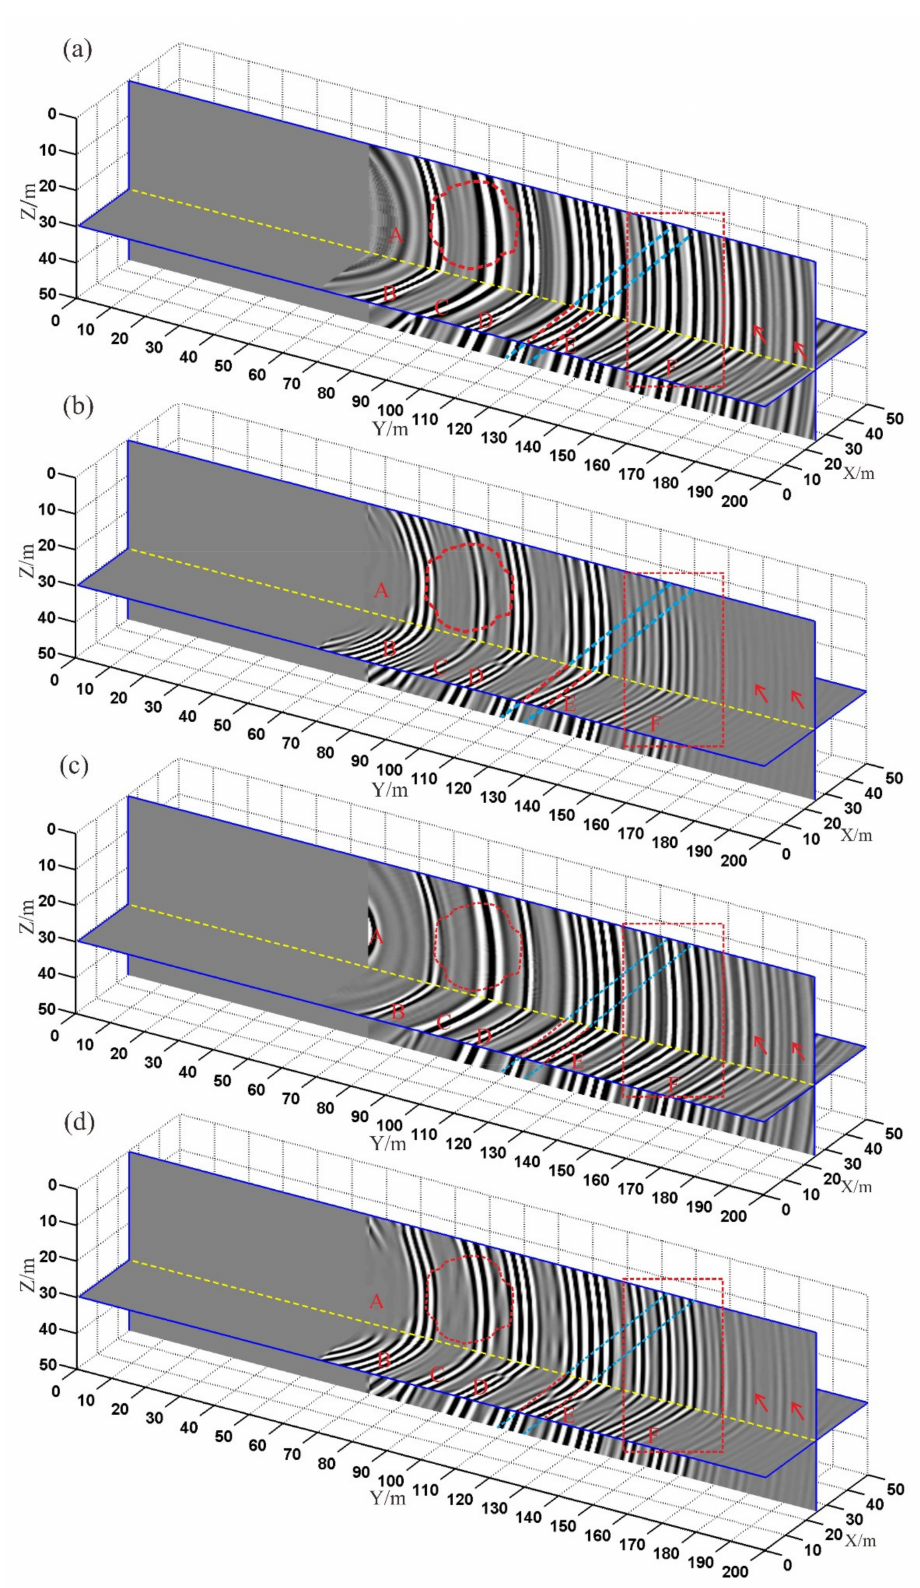
Figure 6. 3-D migration profiles: ( a ) single-component Kirchhoff migration; ( b ) single-component RTM; ( c ) multi-component Kirchhoff migration; ( d ) multi-component RTM. The red circle denotes the karst cave. The light blue and red lines denote the interlayer. The red arrows denote the false anomalous